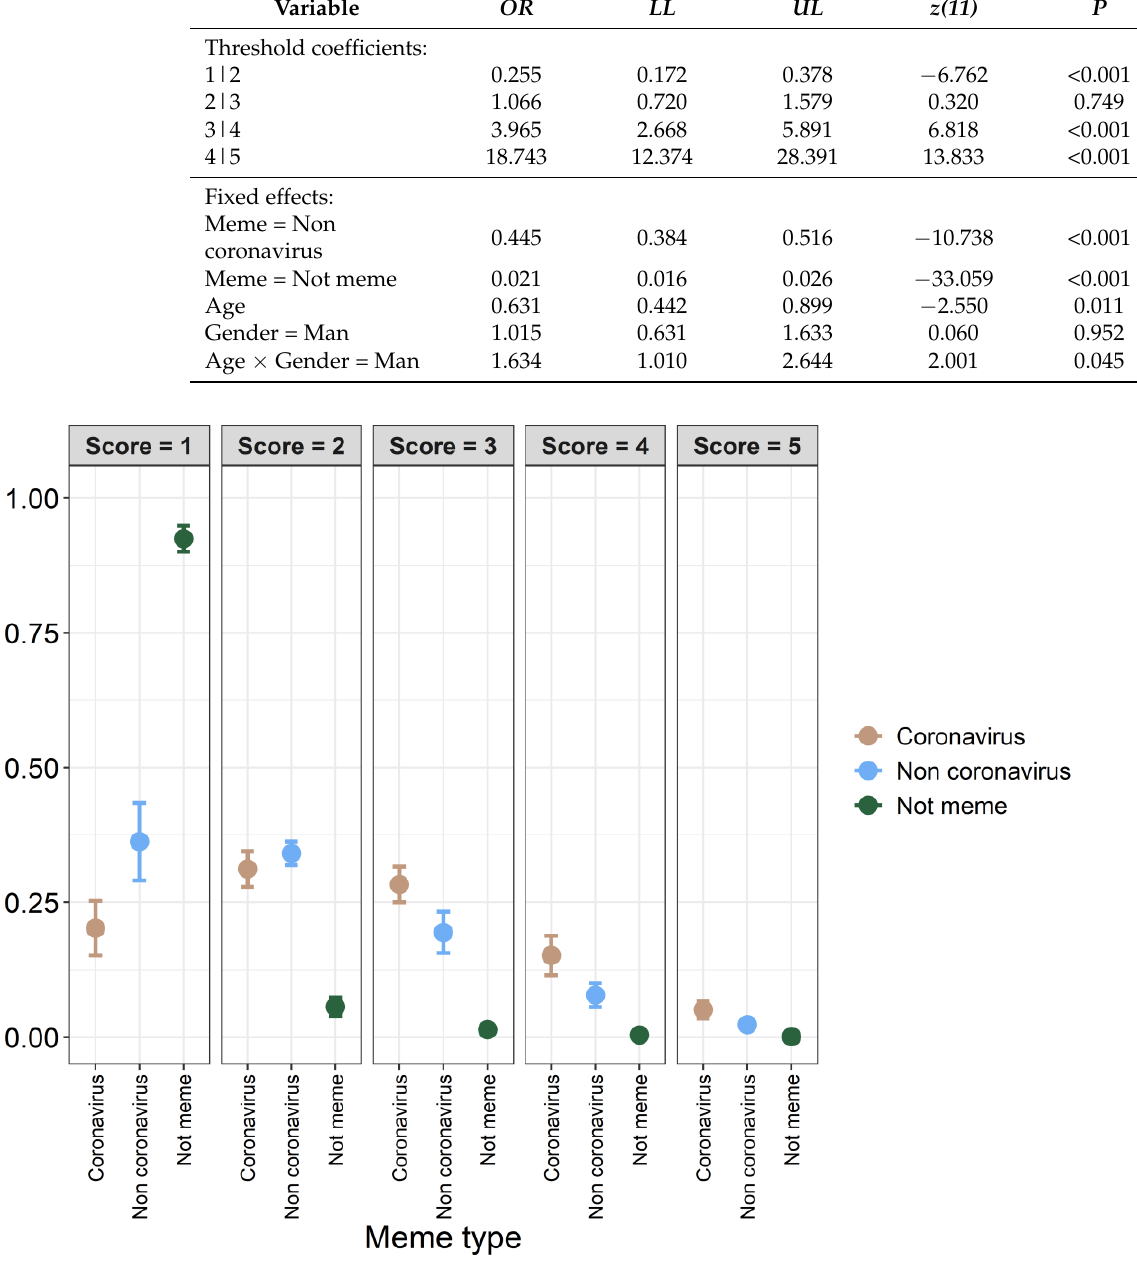
Figure 7. Predicted probability with 95% confidence intervals (whiskers) of the different funniness scores for coronavirus memes, non-coronavirus memes, and sample of images (not memes). The results of the cumulative link mixed model are shown in Table 5. Funniness scores are represented by the gray facet labels. Further explanations are presented in Figure 6.